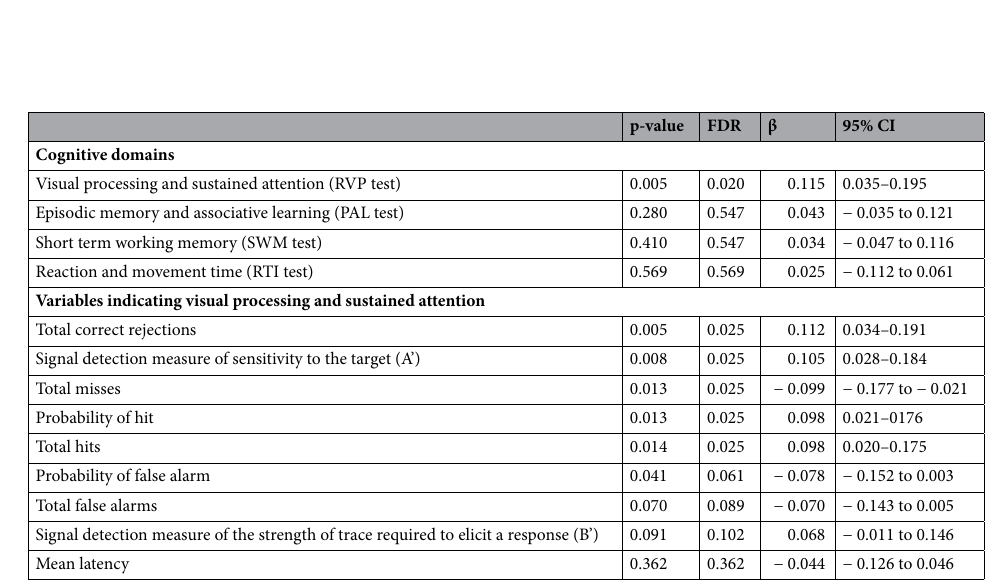
Table 2. Association between hsa-miR-29b-3p levels and cognitive domains and variables indicating visual processing and sustained attention. The association between hsa-miR-29b-3p levels and the cognitive domains was analyzed one by one with linear regression with age, sex, smoking, birth status, leucocyte, erythrocyte and thrombocyte count and liver status as well as parental education years, participants own education level and and polygenic risk score for cognitive function as covariates (MODEL 3). All variables were available from 513 subjects. As the principal component of Rapid visual information processing test was associated with hsa-miR-29b-3p levels the association to the individual variables produced by the CANTAB test battery were also analyzed one by one utilizing the same MODEL 3. Note The CANTAB test battery used to determine the cognitive domains including four separate tests: (1) Paired associates learning (PAL) test, (2) Spatial working memory (PWM) test, (3) Reaction time (RTI) test and (4) Rapid visual information processing (RVP) test. FDR, False discovery rate.